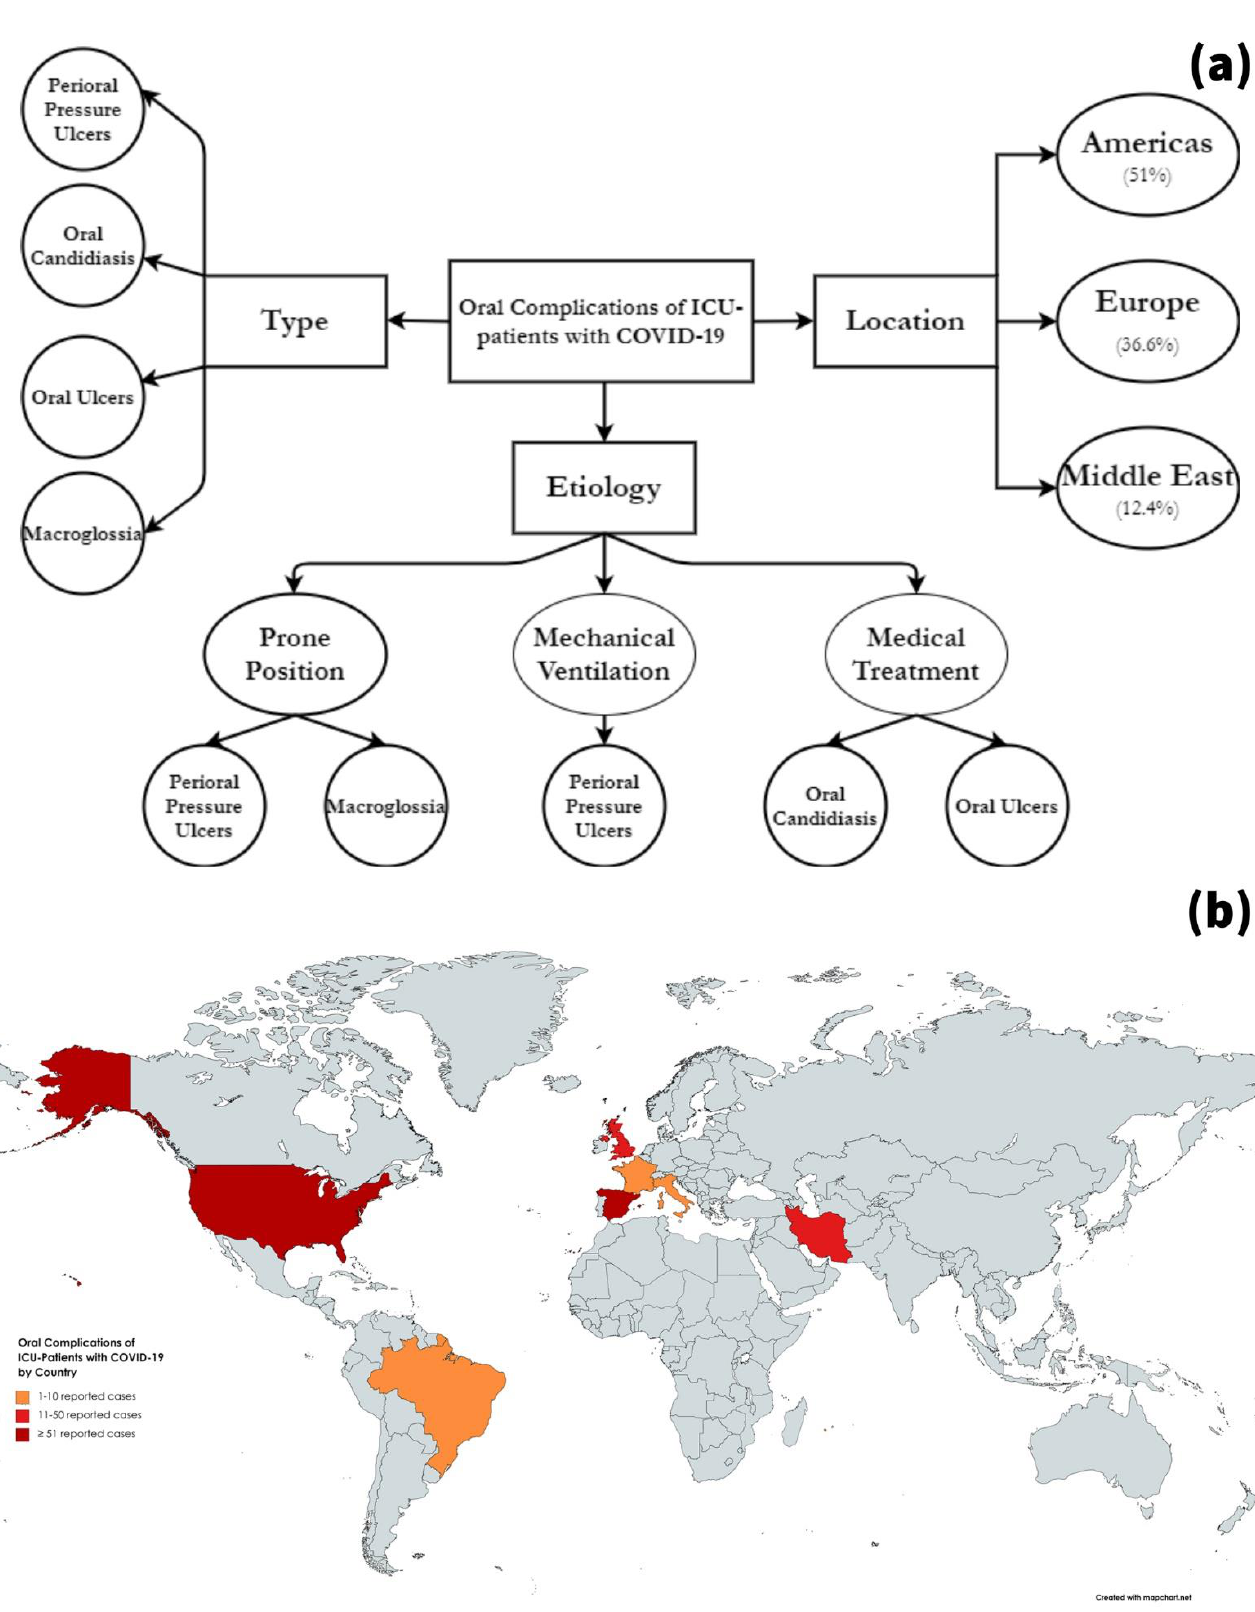
Figure 1. Summary of the oral complications which were reported in the ICU patients with COVID-19; ( a ) by type, aetiology, and region; ( b ) frequency of reported cases by country.